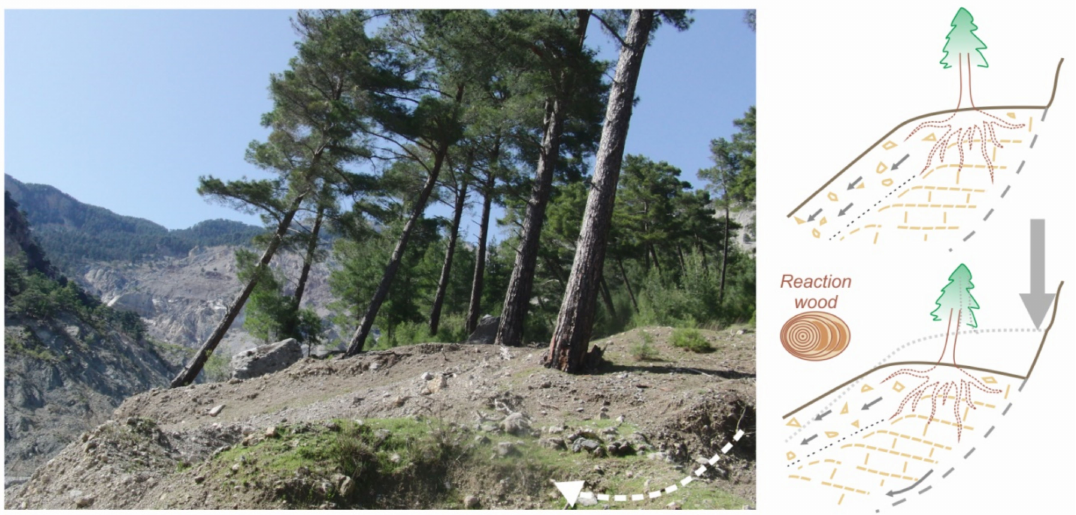
Figure 8. The effect of rotational landslide movements to tree